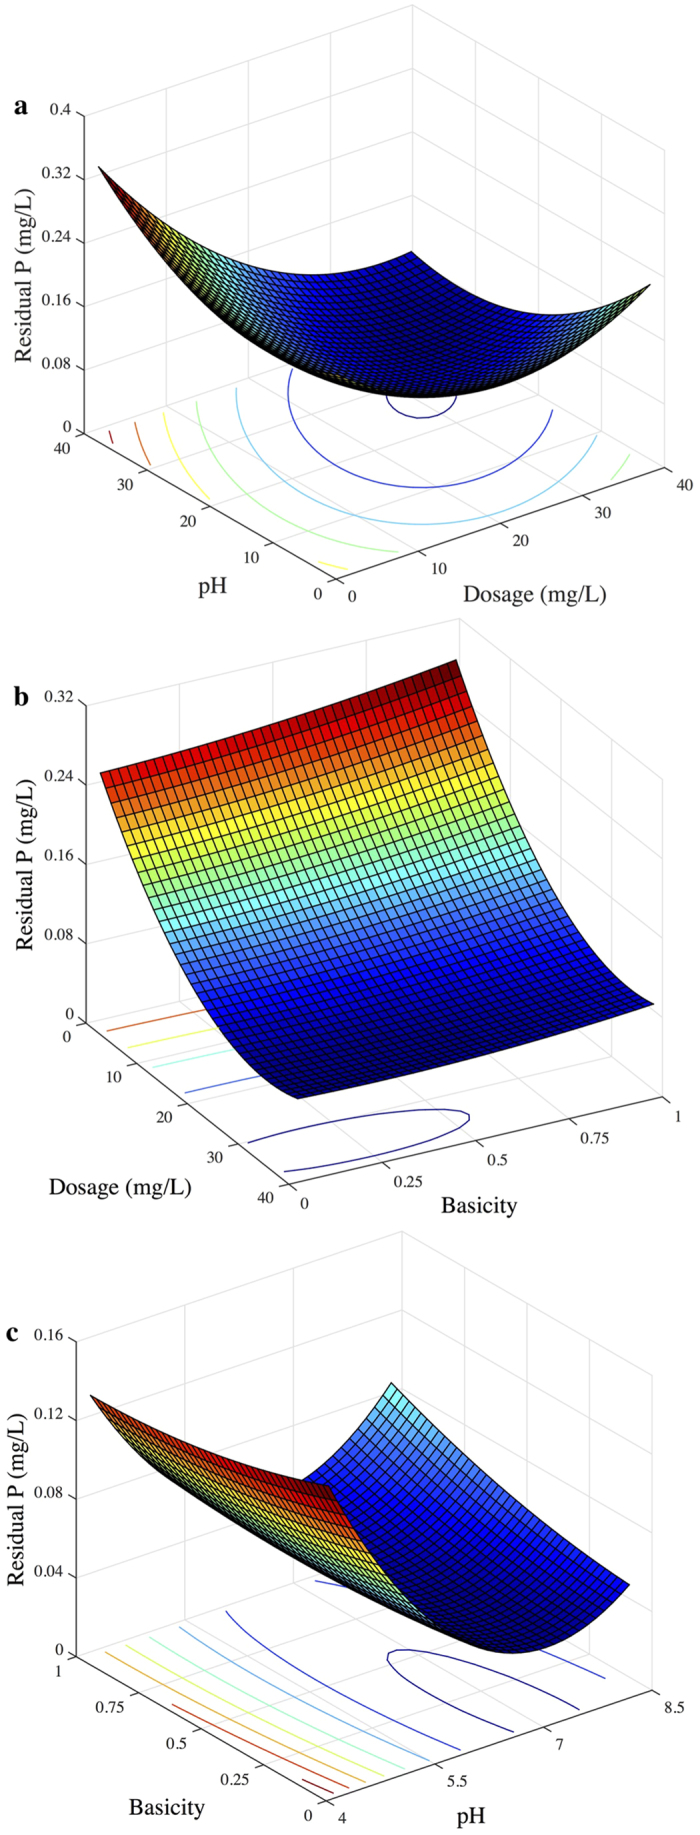
3D surface graphs and contour plots of the residual PO43−-P concentration: effect of variables (a) X1-X2; (b) X1-X3; and X2-X3.